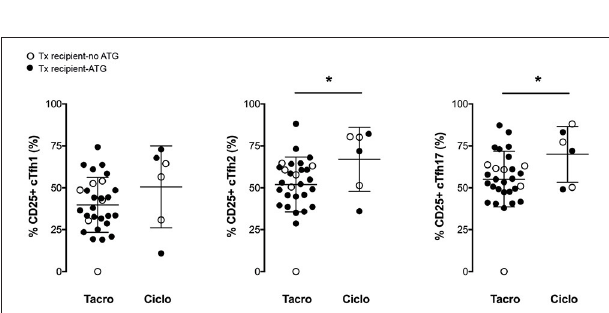
FIGURE 3 | (B–D) The percentage of CD25-expressing cTfh of each of the three subsets ( B : cTfh1; C : Tfh2; D : cTfh17) was enumerated by flow cytometry after 24h of in vitro stimulation in healthy volunteers ( n = 9; controls, Ctl; open triangles), and transplant patients ( n = 36, circles). The nature of induction immunosuppressive therapy received by transplant patient is indicated. Transplant patients were distributed into two groups according to the time elapsed since transplantation: (i) 6–12 months: early post-transplantation (Early Tx; n = 18), and (ii) > 12–72 months: late post-transplantation (Late Tx; n = 18). Dotted line indicates the lower threshold of the percentage of cTfh expressing CD25 after stimulation in control patients. (E–G) The level of expression of CD25 (as reflected by mean fluorescence intensity, MFI) was measured by flow cytometry after 24h of in vitro stimulation for each of the three subsets of cTfh ( E : cTfh1; F : Tfh2; G : cTfh17) and compared between the three groups. Each symbol represents a patient, mean ± SD is indicated. * p < 0.05; ** p < 0.01; *** p < 0.001; **** p < 0.0001; ANOVA, Dunn’s multiple comparisons test.